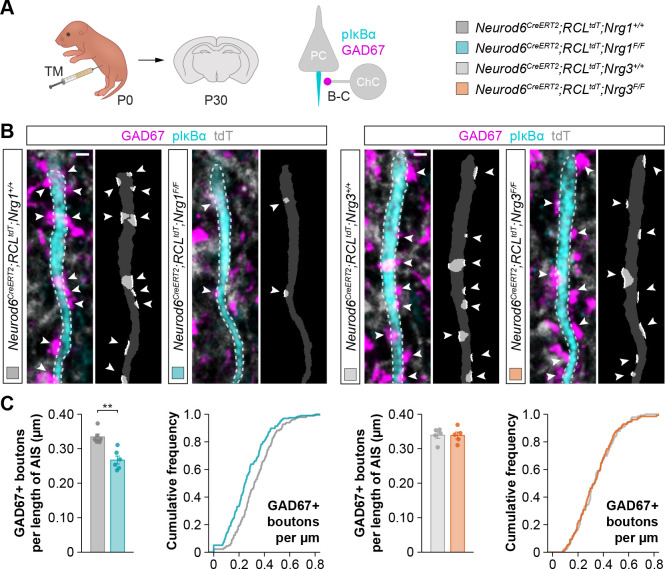
Loss of axo-axonic boutons in cortical pyramidal cells lacking Nrg1 but not Nrg3, related to Figure 1.(A) Schematic of experimental design. Conditional deletion of Nrg1 or Nrg3 in pyramidal cells (PC) was achieved by tamoxifen (TM) injection in newly born pups at P0. Inhibitory synapses made by chandelier cells (ChC) onto the axon initial segment (AIS) of pyramidal cells (GAD67, pIκBα) were analyzed in these experiments. (B) Confocal images (left) and binary images used for quantification (right), showing GAD67+ boutons (magenta, arrowheads) contacting the AIS (cyan) of pyramidal cells in controls, Nrg1 and Nrg3 conditional mutant mice. (C) Quantification of the density of axo-axonic inhibitory boutons contacting pyramidal cells in controls, Nrg1 and Nrg3 conditional mutant mice. Mann-Whitney U-test: for Neurod6CreERT2;RCLtdt;Nrg1, **p<0.01; n = 6 mice (178 cells) for controls and six mice (196 cells) for mutants. Two-tailed Student’s t-test: for Neurod6CreERT2;RCLtdt;Nrg3, p=0.959; n = 5 mice (139 cells) for controls and 5 mice (127 cells) for mutants. ChC, chandelier cell; PC, pyramidal cell. Scale bars, 1 µm. Data are shown as mean ± s.e.m. The averages per animal and genotype are represented in bar graphs, and the distributions of values per cell are shown in cumulative frequency plots. Data used for quantitative analyses are available in Figure 1—figure supplement 4—source data 1.
Figure 1—figure supplement 4—source data 1.Numerical data of axo-axonic synapses in conditional mutant mice for Nrg1 and Nrg3.